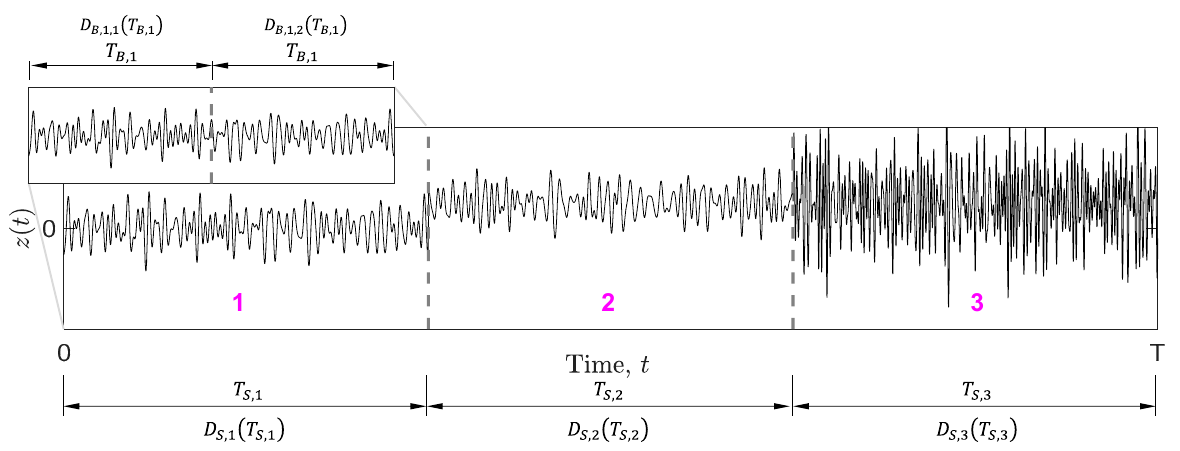
Figure 1. Non-stationary switching stress-time history with 3 stationary states and 2 blocks in each state.